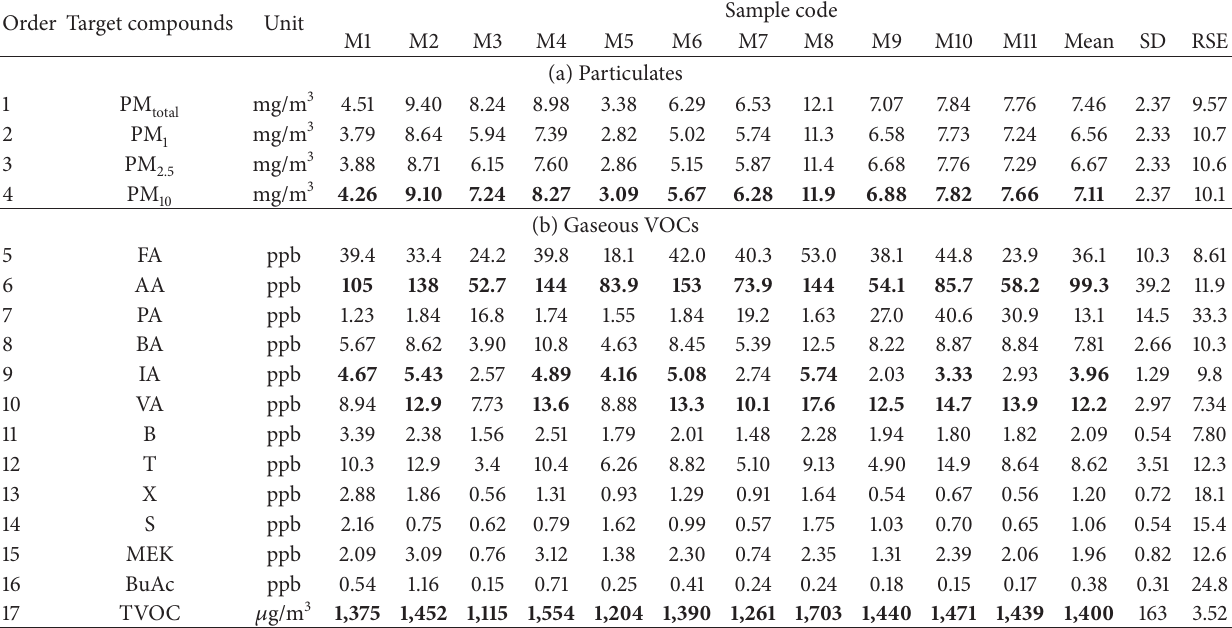
Table 3: Concentrations of PM and gaseous VOCs released from mackerel samples by the pan frying. Order Target compounds